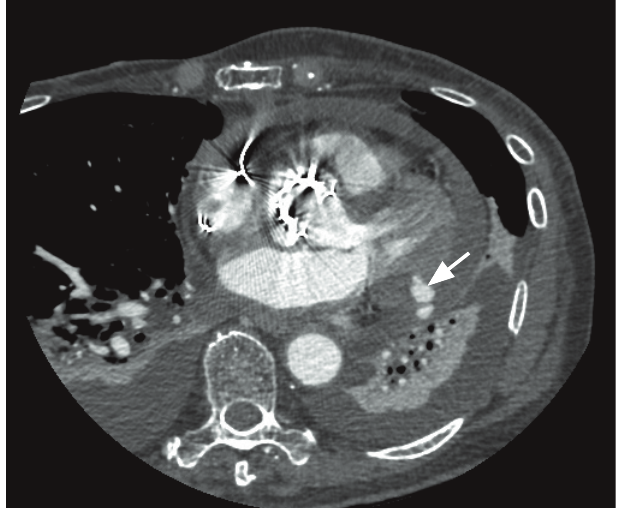
Fig. 1. Axial CT showing a thin tract of contrast extending into the myocardium and leading up to a small pseudoaneurysm in the posterolateral aspect of the left ventricular free wall.